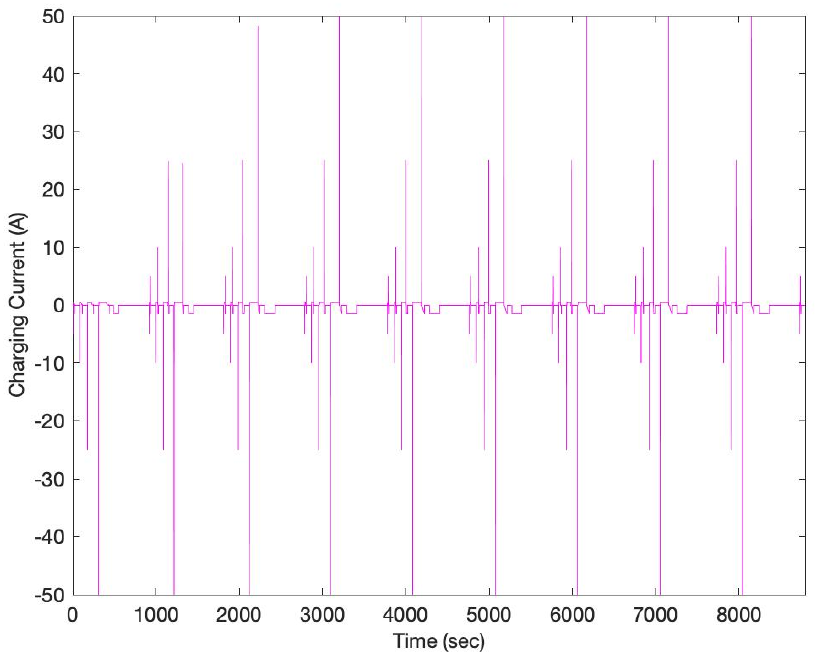
Figure 11. The experimental charging/discharging profiles for the Turnigy graphene battery dataset over time.